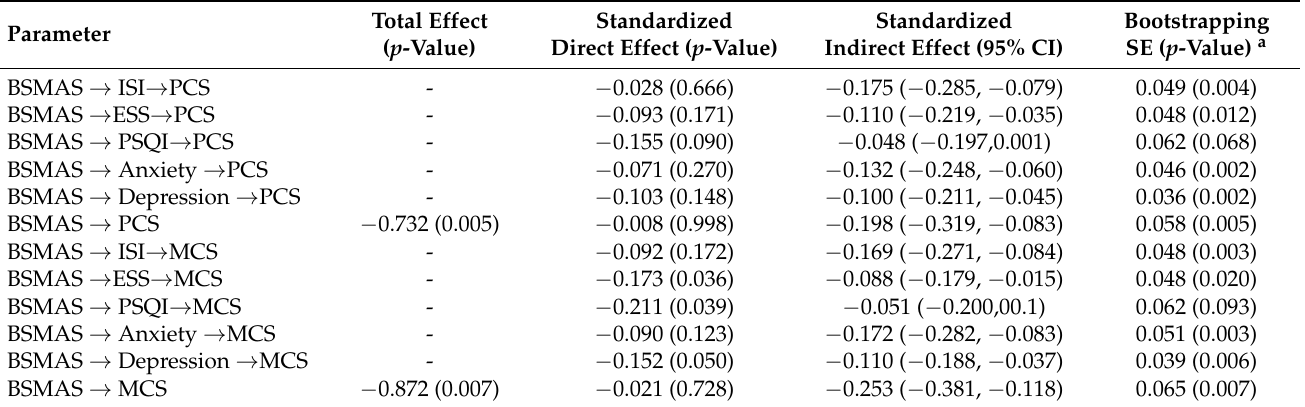
Table 3. Standardized effects (including direct, indirect, and total effects) of the relationship between problematic social media use and health-related quality of